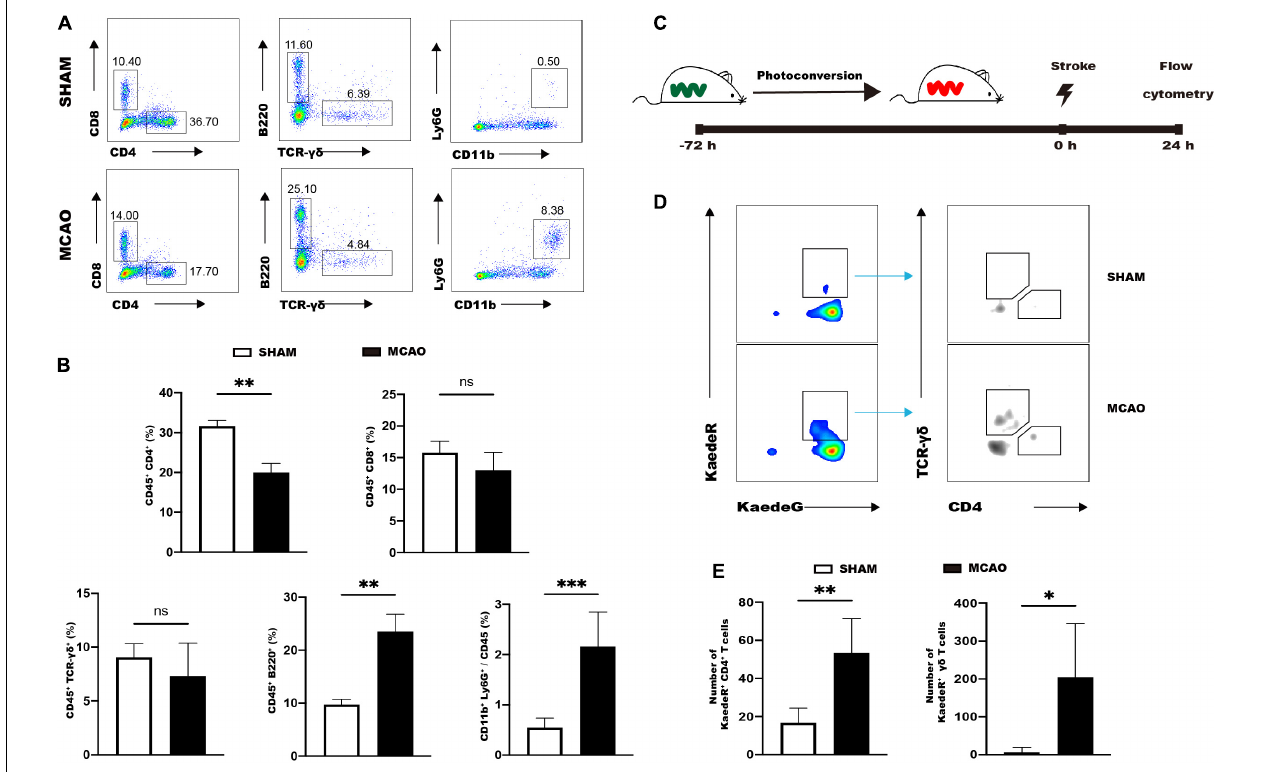
FIGURE 5 | Intestinal immune cells rapidly respond to ischemic stroke. (A) Representative flow cytometry analysis of immune cells in the small intestine 1d after MCAO or sham operation. (B) Quantifications of immune cells in the small intestine. n = 5:5. (C) Strategy for analyzing intestinal immune cell trafficking to the brain by using Kaede transgenic mice. (D) Representative flow cytometry analysis of photoconverted CD4 + T cells and γδ T cells in the ischemic brain. (E) Quantifications of photoconverted CD4 + T cells and γδ T cells. n = 4:6. Values represent mean ± SD . Student’s t -test was used for statistical analysis. ns, not significant; ∗ p < 0.05 ∗∗ p < 0.01, ∗∗∗ p <